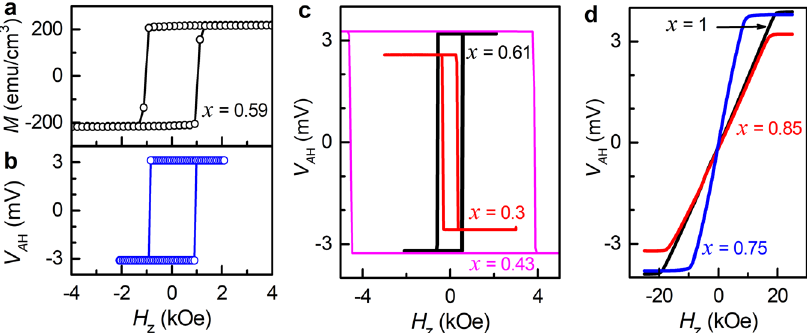
Fig.1|MagnetizationandanomalousHallvoltagehysteresis.a Magnetizationvs out-of-plane fi eld ( H z ) and b Anomalous Hall voltage ( V AH ) vs H z for Pt 0.75 Ti 0.25 (5.6nm)/Fe 0.59 Tb 0.41 (8nm)underasinusoidalelectric fi eld E =30kV/m,indicating